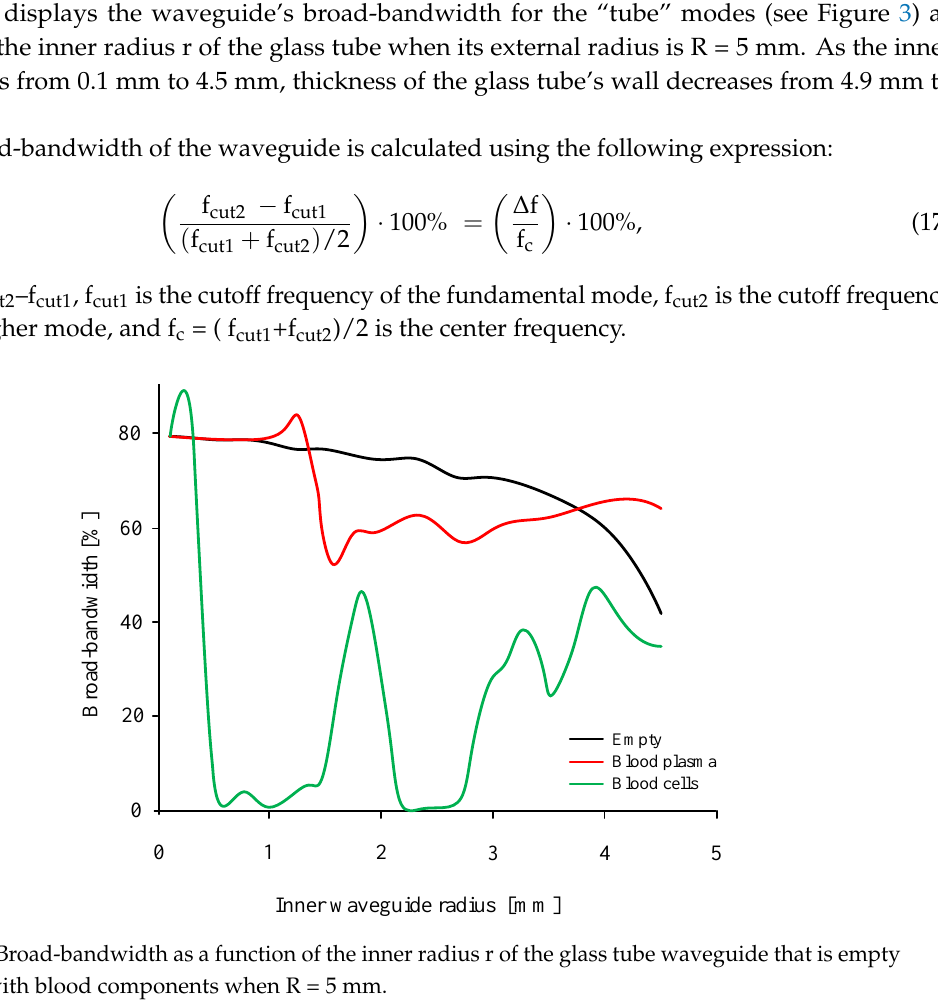
Figure 5. Broad-bandwidth as a function of the inner radius r of the glass tube waveguide that is empty or filled with blood components when R = 5